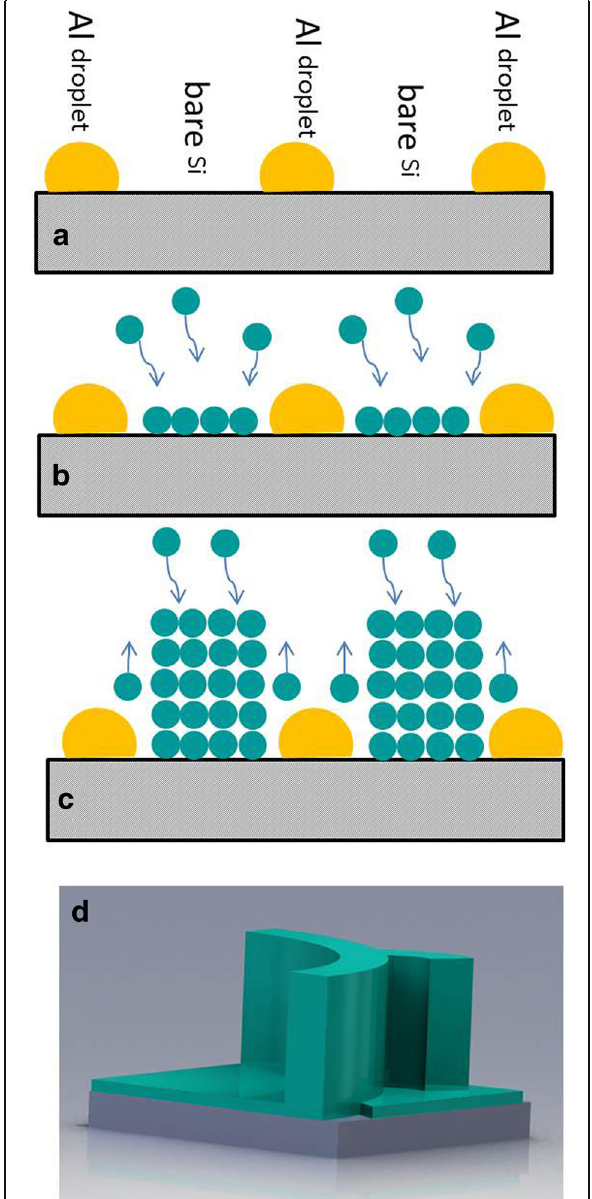
Fig. 3 Growth models of the GaN nanowall network. a The pre-deposited Al droplets on the Si substrate. b Nucleation of the GaN nanowall network on the bare Si. c Cross-sectional illustration of the GaN nanowall network grown vertically at the N-rich condition. d Tilt illustration of the GaN nanowall